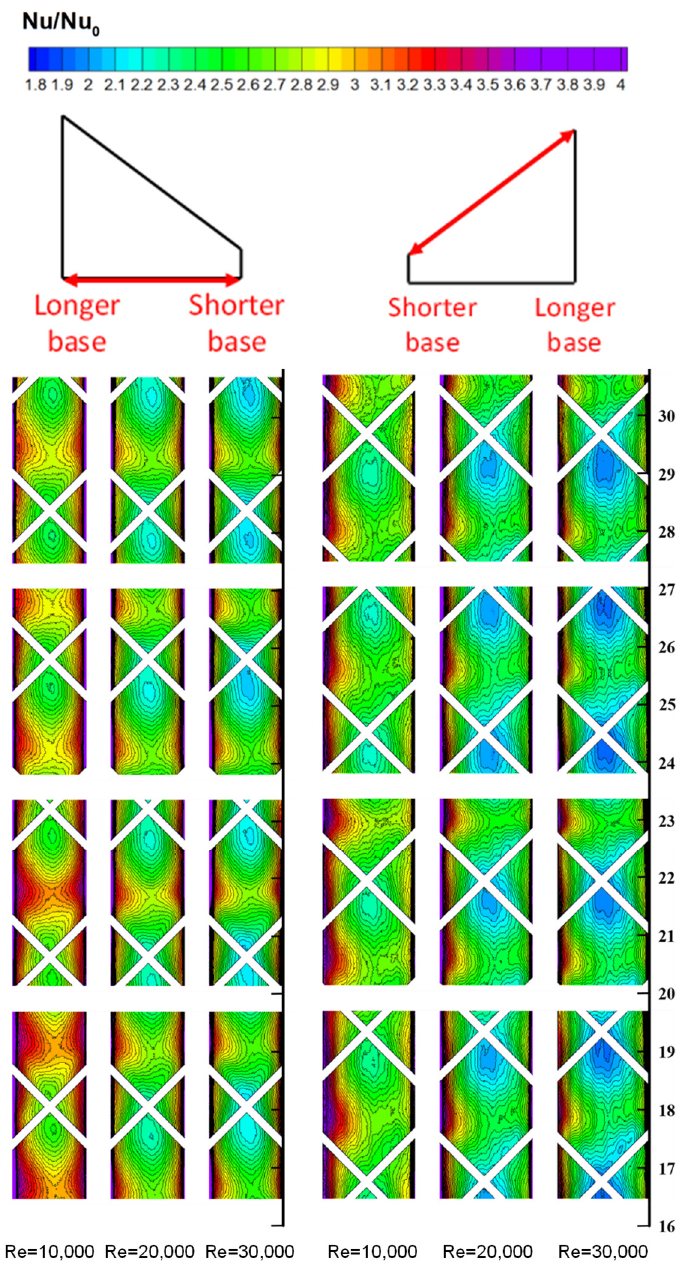
Figure 7. Nusselt number ratios for the X-shaped rib ( P/e = 20).